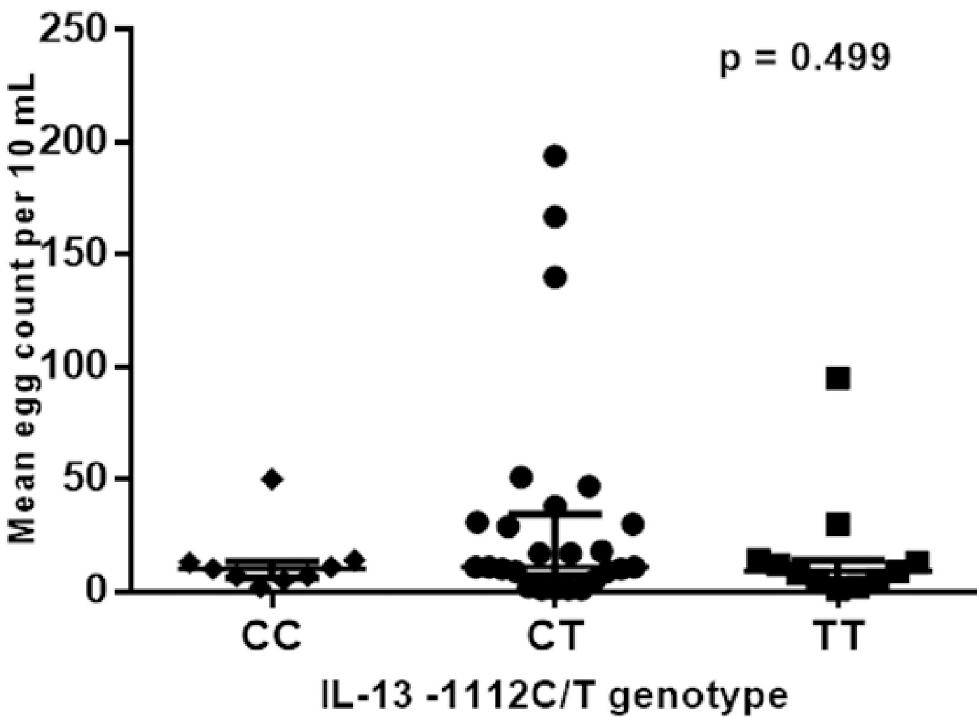
Fig 5. Comparison of the mean egg burden between IL-13 (rs1800925) variants among S . haematobium infected males. are consistent with the recent findings by Adedokun et al . (2018) who, despite working on dif- ferent promoter positions found insignificant differences in the IL-13 (rs7719175) genotypic or allelic frequencies between schistosome-infected and uninfected controls; and any associa- tion with disease [38]. We found that IL-13 genotype variants are indicative of IL-13 cytokine concentrations, with the highest levels in schistosomiasis uninfected individuals with heterozy- gous CT variants compared to the homozygous TT variant of the schistosomiasis uninfected group. Additionally, a combination of the homozygote IL-13-1112 CC and heterozygote IL- 13-1112CT variants significantly had higher IL-13 cytokine levels compared to IL-13-1112TT variant implying an association between IL-13-1112C/T promoter genotype and IL-13 cyto- kine levels. The results illustrated that IL13-1112CT genotype exhibited the most frequent dis- tribution among the study population and there were higher schistosomiasis prevalence and infection intensity of individuals with IL13-1112CT variant. Apparently, IL-13-1112C variant